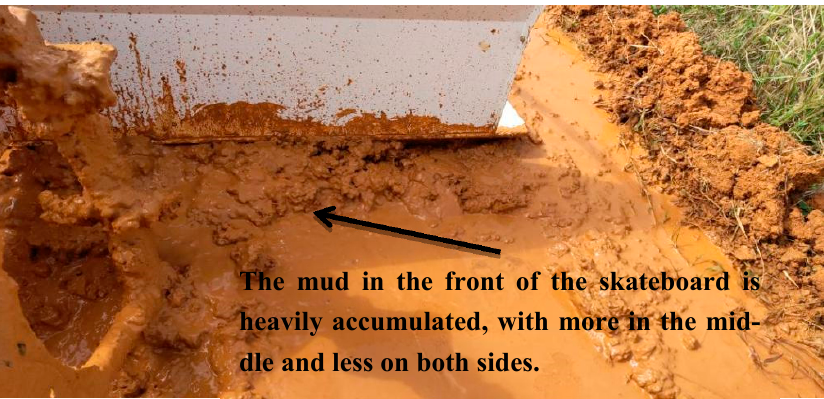
heavily accumulated, with more in the mid- dle and less on both sides. dle and less on both sides. Figure 25. Mud accumulation in front of skateboard. Figure 25. Mud accumulation in front of skateboard. Figure 25. Mud accumulation in front of skateboard.